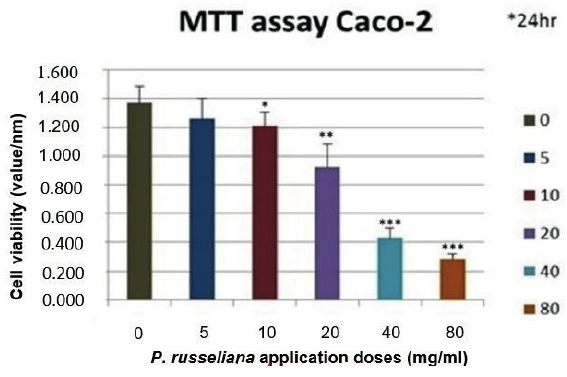
Figure 1 - The effects of different dose P. russeliana treatments with 5; 10; 20; 40; 80 mg/ml on cell viability of colon cancer (Caco-2) cell line. *p < 0.001 is 10 mg/ml concentration through **p < 0.001 20; 40 mg/ml concentration and ***P < 0.001 is 80 mg/ml treatment concentration as compared to the negative control group up to 24 h